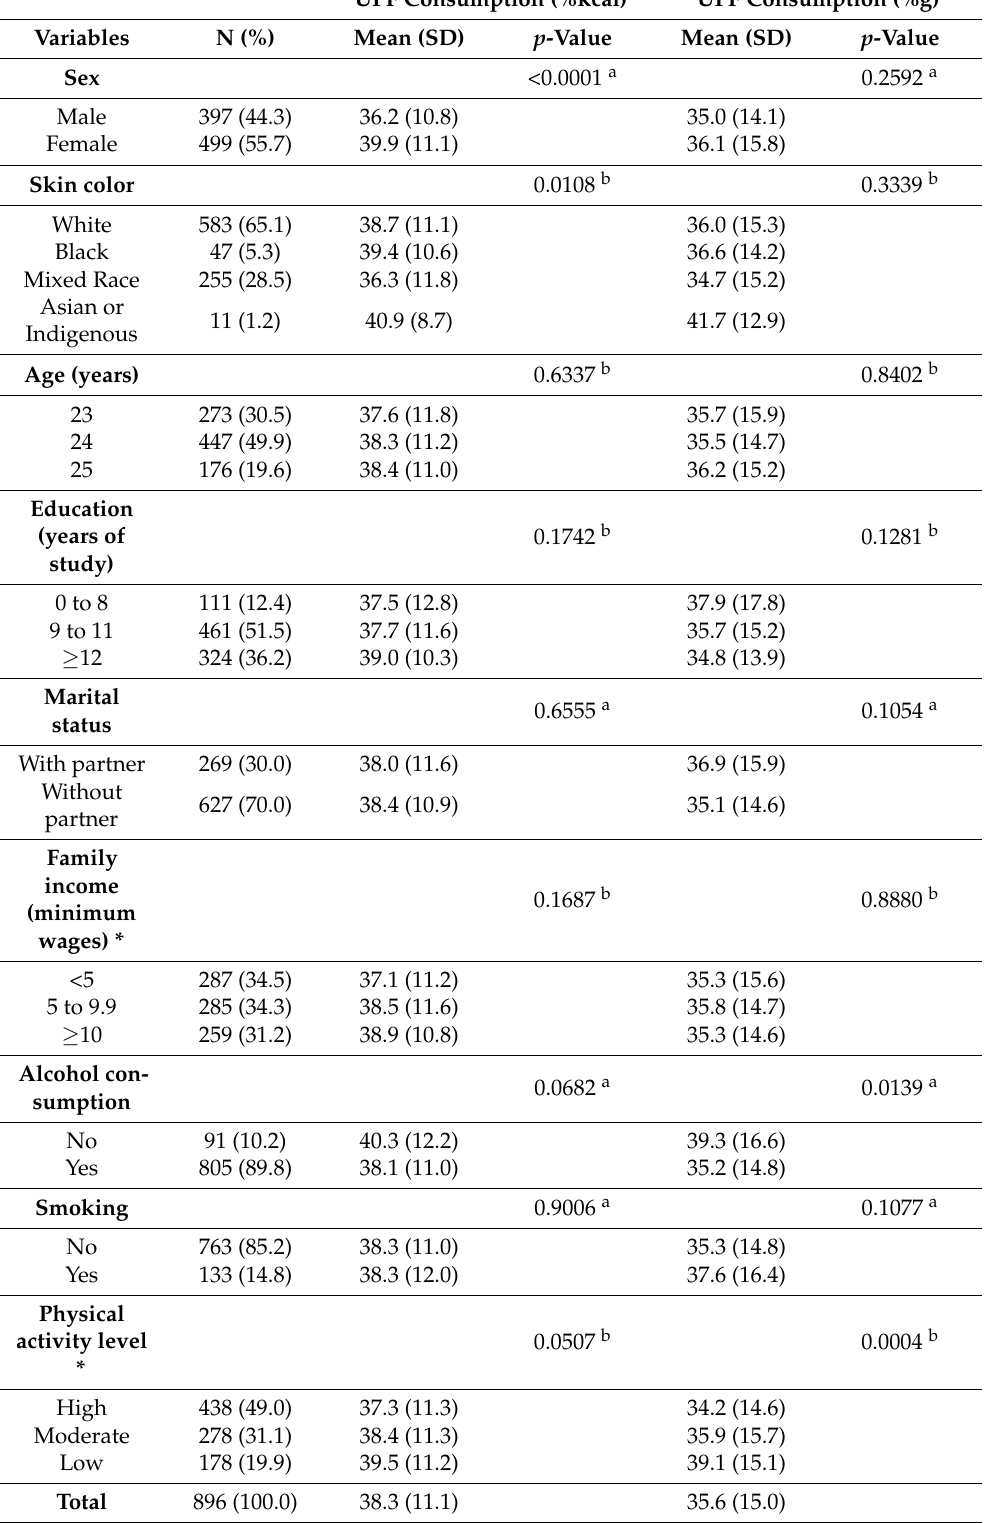
Table 1. Mean and standard deviation (SD) of the ultra-processed food (UPF) consumption at 23–25 years according to demographic, socioeconomic, and lifestyle characteristics of the